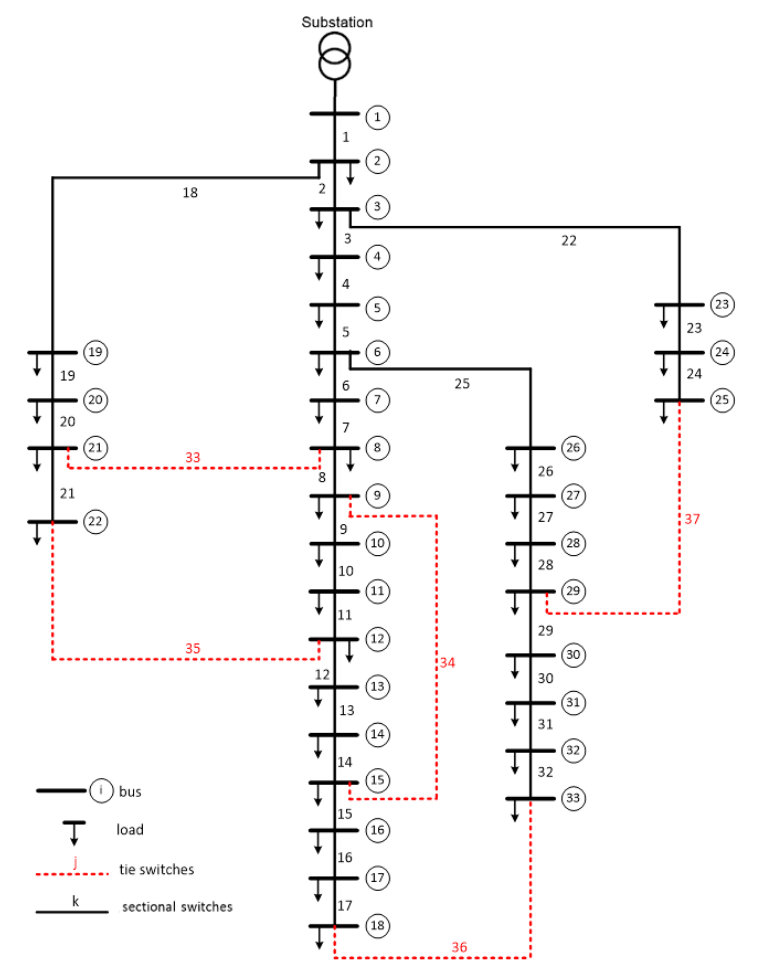
Figure 3. The initial configuration of the IEEE model distribution network